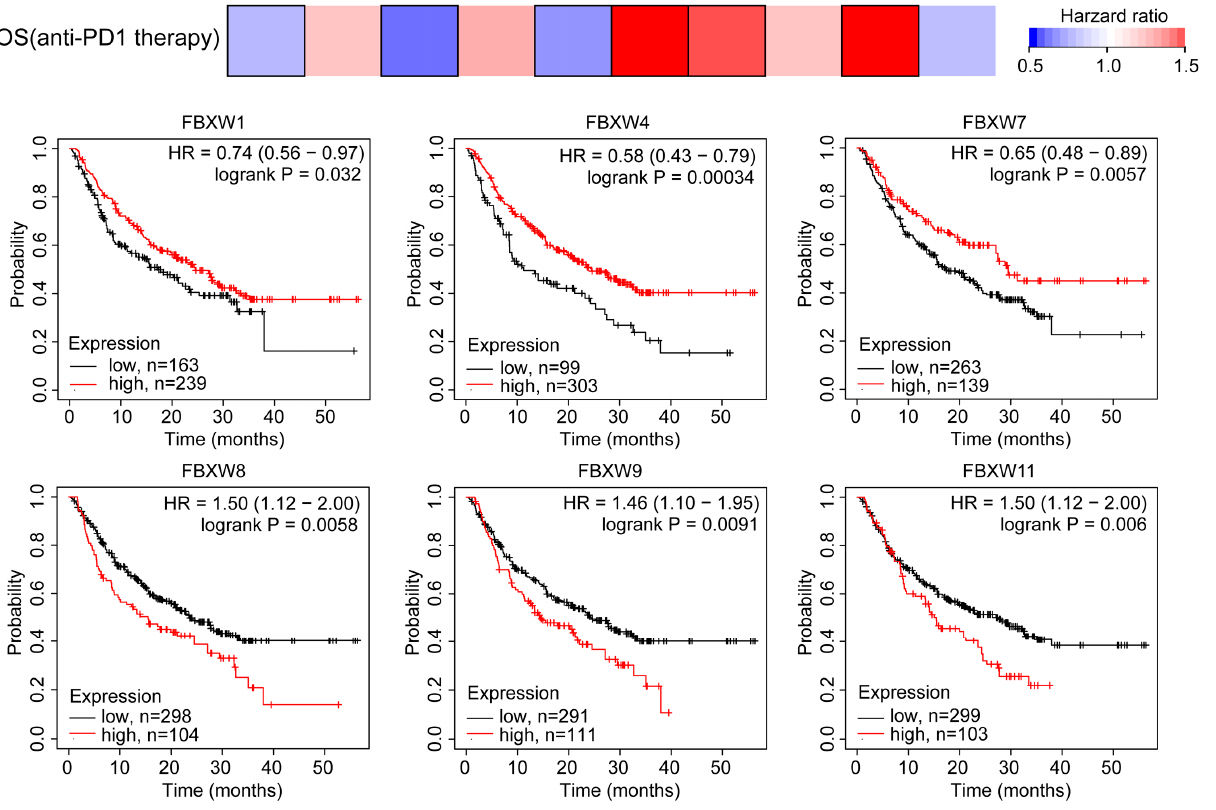
Figure 3. Pan-cancer analysis of expression of FBXWs, tumor microenvironment, and the overall survival of patients receiving anti-PD1 therapy.